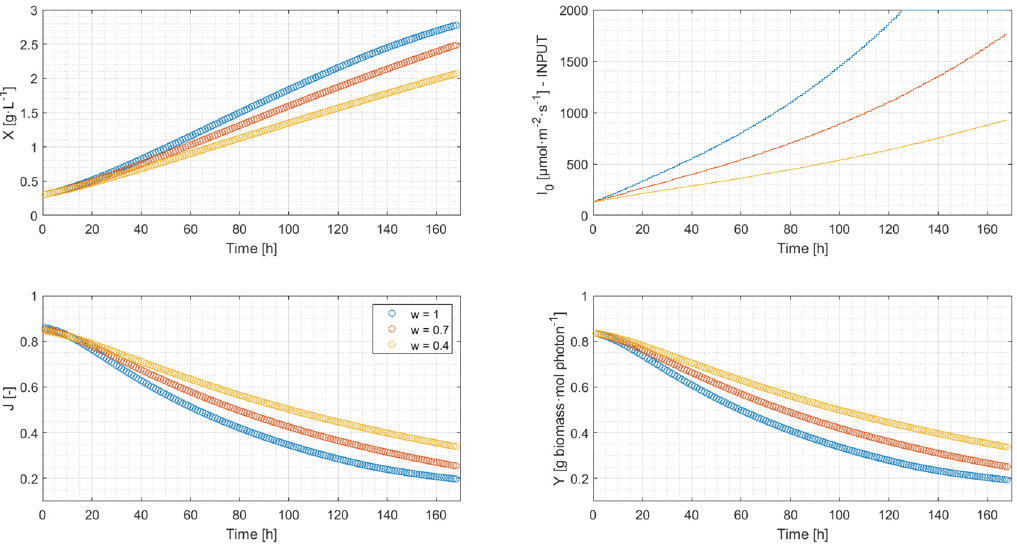
Figure 9. Simulation results on a seven ‐ day batch with different weighing factors (see Equation = 1, with red w = 0.7 and with yellow w = (15)). With blue 𝑤 (cid:3404) 1 , with red 𝑤 (cid:3404) 0.7 and with yellow 𝑤 (cid:3404) 0.4 . With blue w